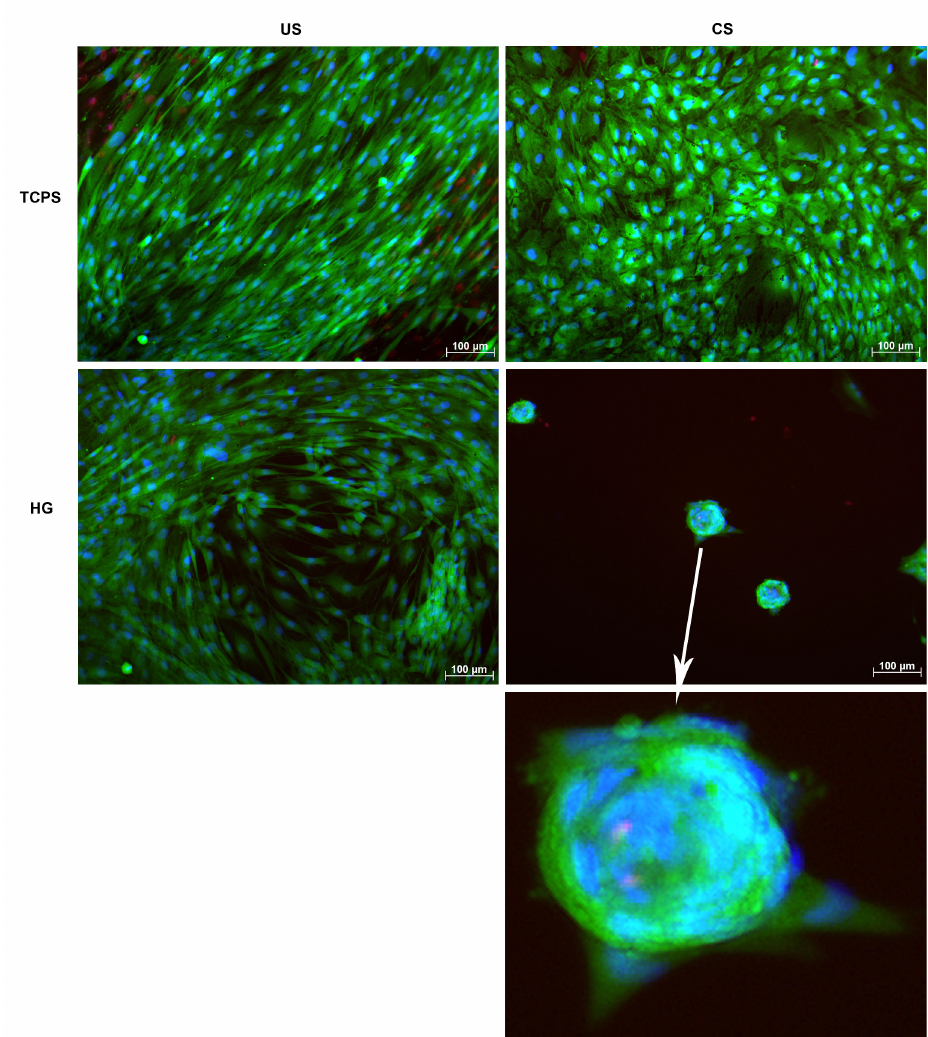
Figure 2. Phenotype of adMSC on hydrogels after 28 days of chondrogenic